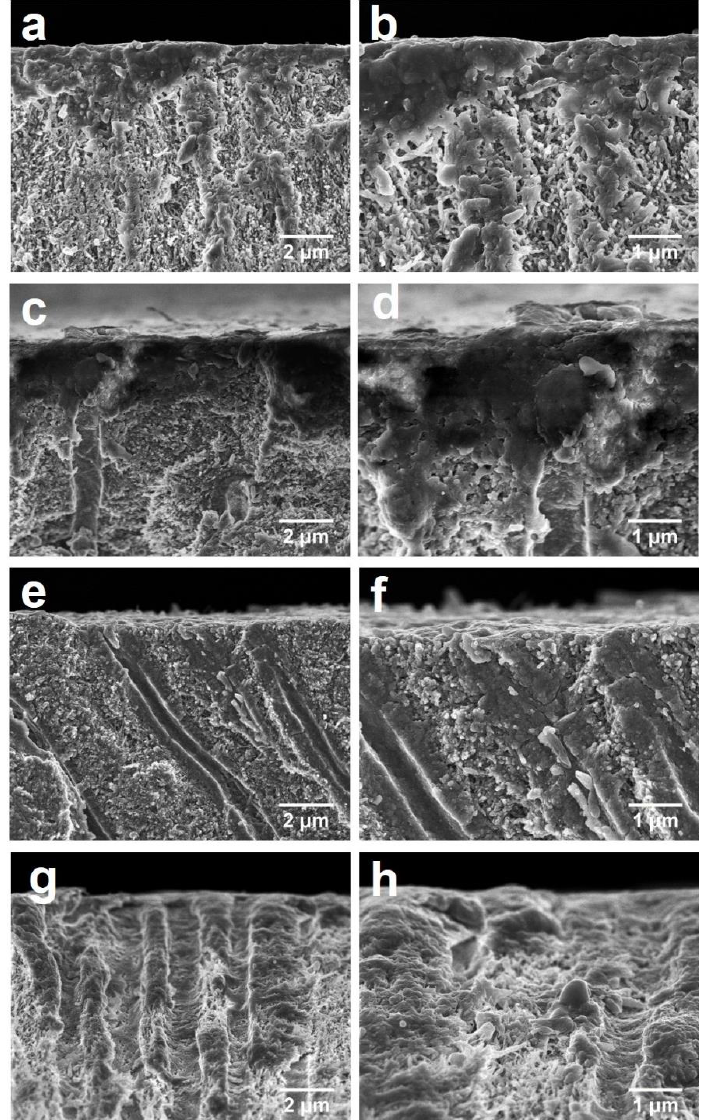
Figure 3. SEM images of the cross-sectional (longitudinal) surface of dentine. ( a ) 4000× magnification view of Group 1 (SBAG); ( b ) 8000× magnification view of Group 1 (SBAG); ( c ) 4000× magnification view of Group 2 (SBAG+F); ( d ) 8000× magnification view of Group 2 (SBAG+F); ( e ) 4000× magnification view of Group 3 (F); ( f ) 8000× magnification view of group 3 (F); ( g ) 4000× magnification view of Group 4 (Control); and ( h ) 8000× magnification view of Group 4 (Control). Table 1 lists the details of the depth and mineral loss of the lesions in enamel and dentine. The mean lesion depths of dentine in Groups 1 to 4 were 81.80 ± 12.39 μm, 30.68 ± 17.91 μm, 39.04 ± 17.99 μm and 146.36 ± 36.86 μm, respectively ( p < 0.001). Group 2 and Group 3 had a mineral loss of 0.88 ± 0.15 g/cm 3 and 0.87 ± 0.19 g/cm 3 , respectively, which were less than those in Groups 1 and 4 ( p < 0.001). Besides, the dentine mineral loss in